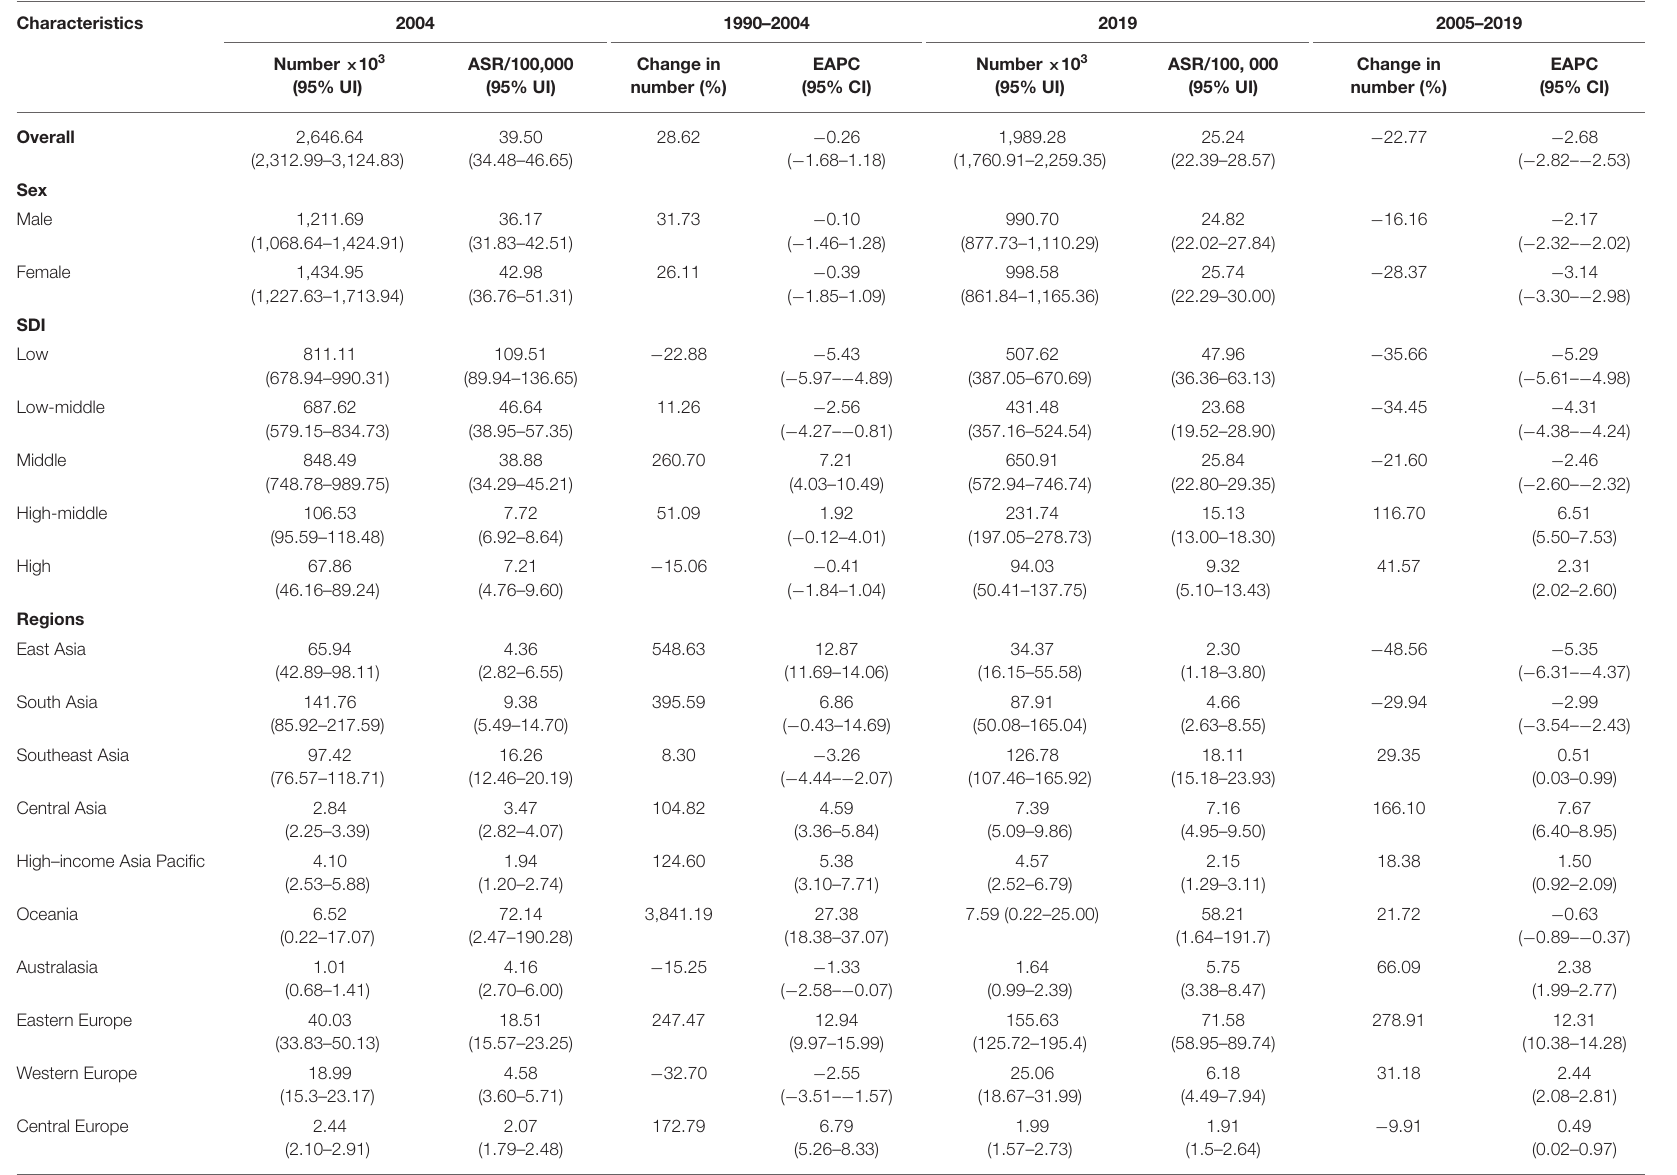
TABLE 1 | Percentage changes in the absolute number and the EAPCs of HIV/AIDS incidence from 1990 to 2019 globally, stratified by sexes, SDI areas, and geographic regions.